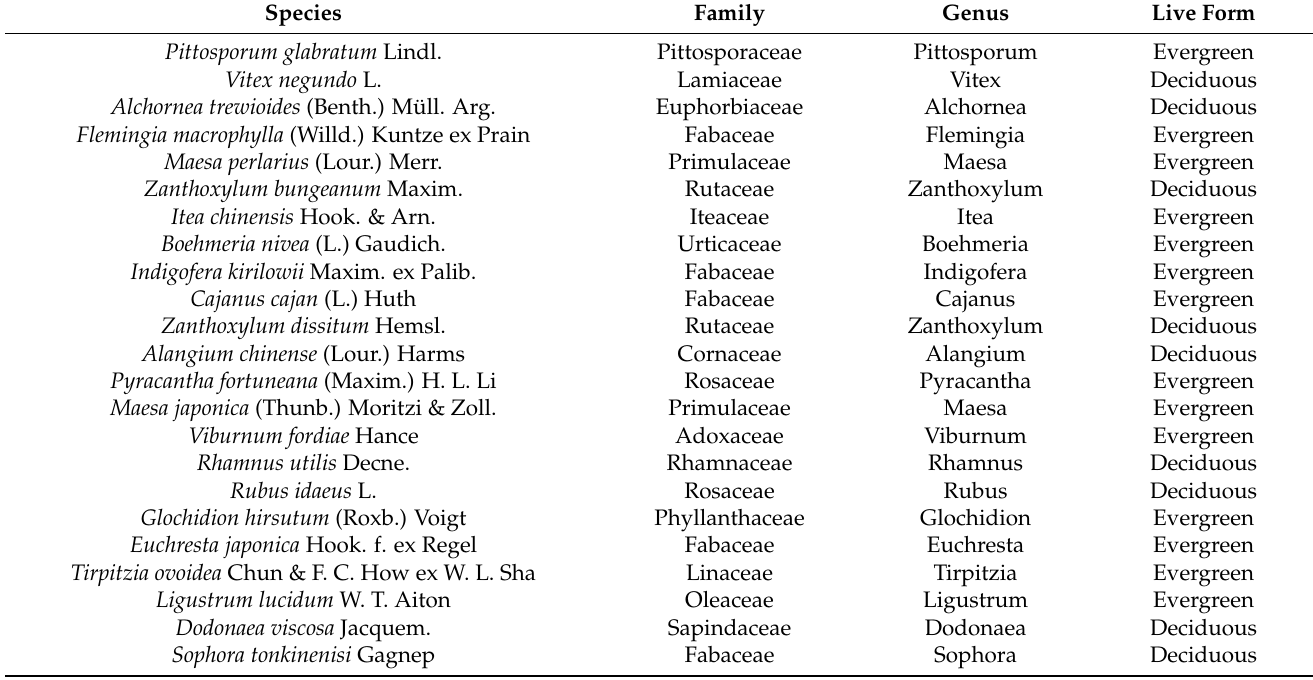
Table A1. The plant catalogue of the sample